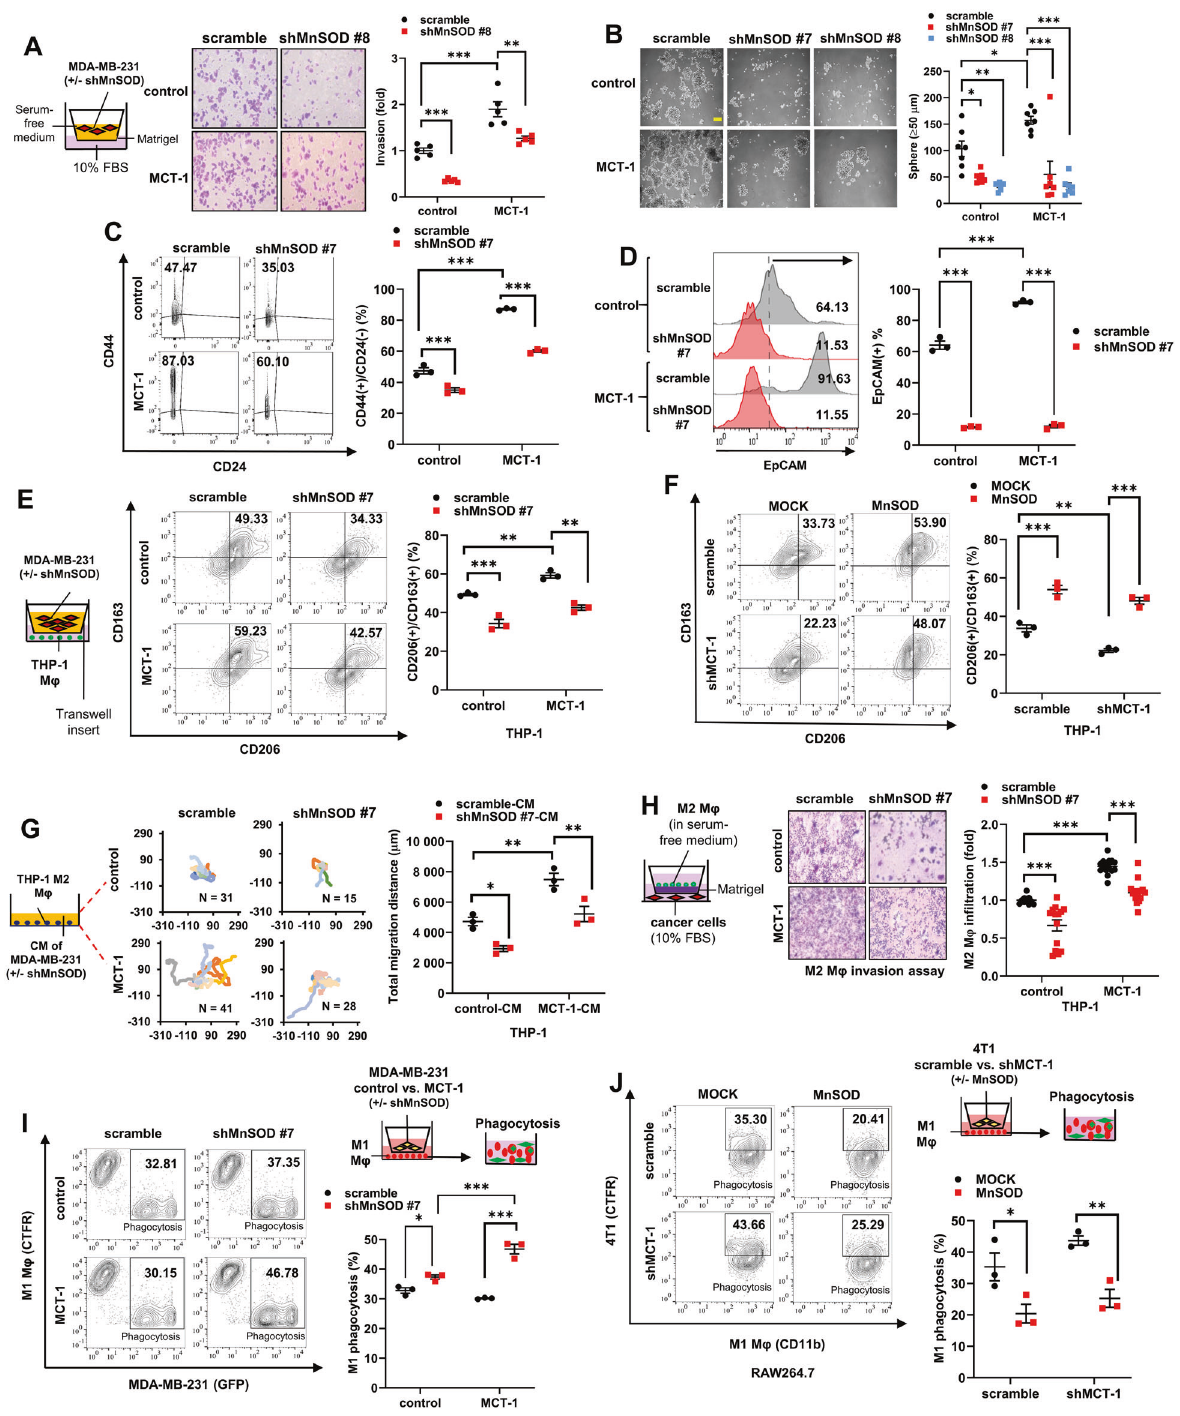
advanced stages (III/IV) (96%) (Fig. 2F), in the subtypes HER2( + ) (94%) and TNBC (93%) and in patients with metastasis to the lymph nodes (N1-3) (96%) or the distant metastasis (M1) (100%) (Fig. 2G). Breast cancer patients with high NFE2L2 expression had a lower RFS rate than those with low NFE2L2 expression ( p < 0.001) (Supplementary Fig. S1B). Patients with the basal-like subtype of invasive breast cancers and MCTS1 high / NFE2L2 high expression